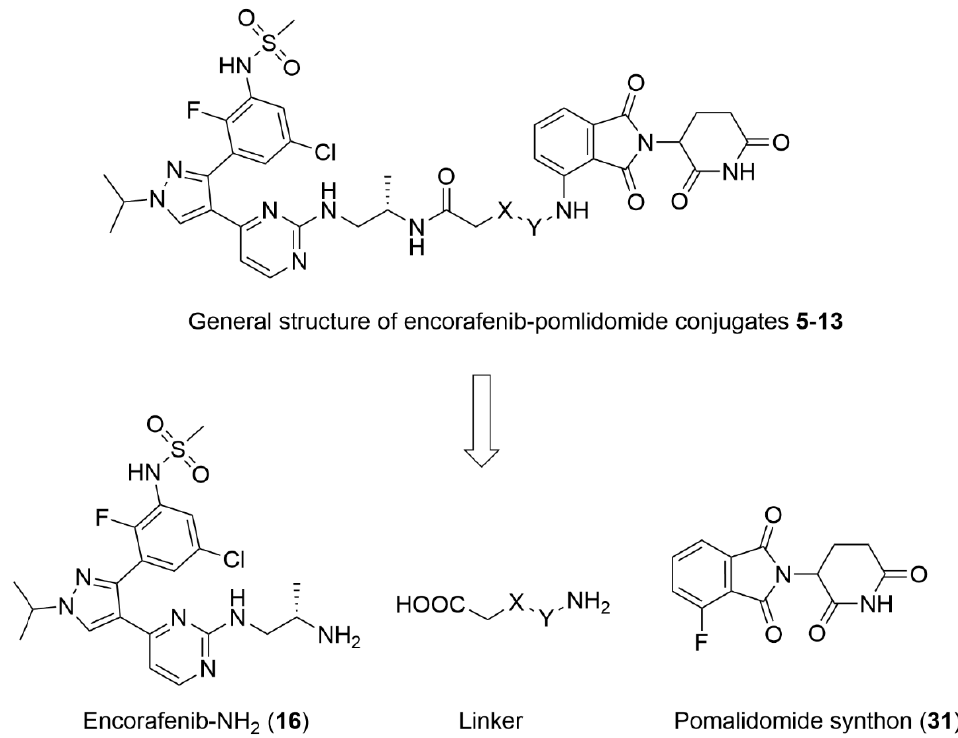
Figure 3. General strategy for the synthesis of encorafenib conjugates.